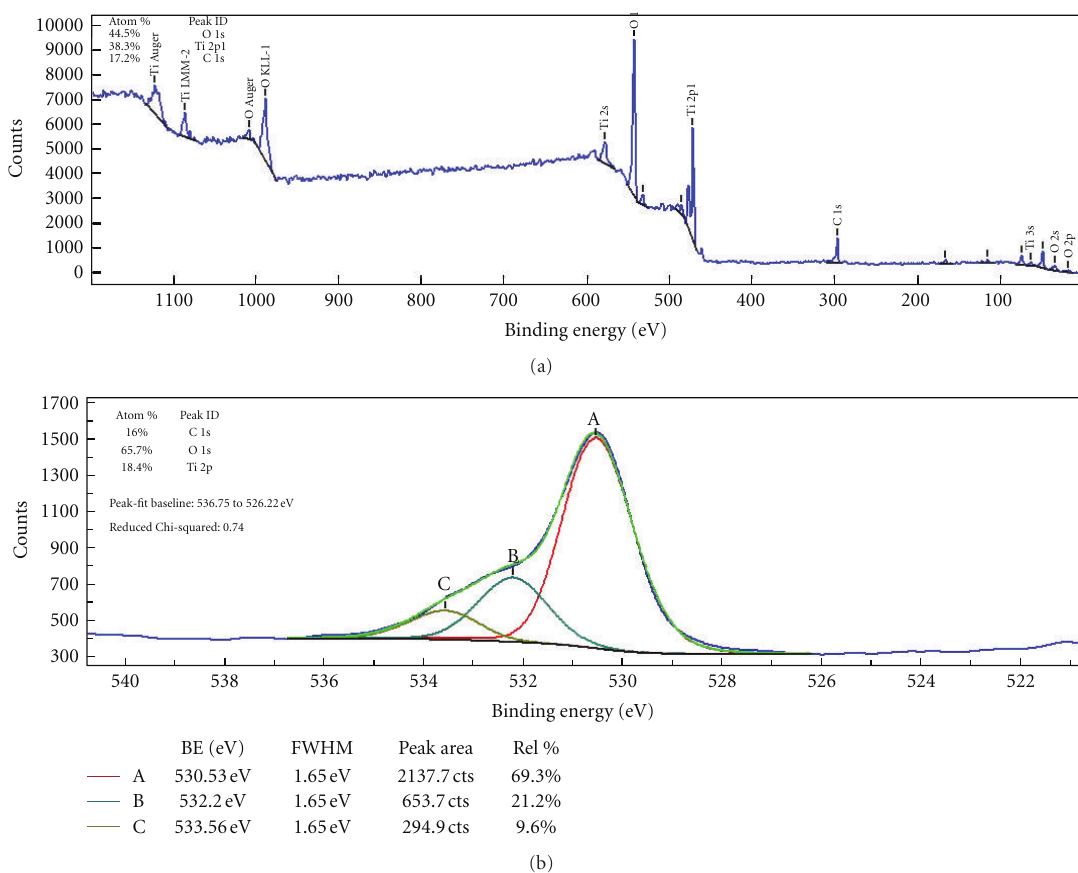
Figure 8: XPS spectra of the TiO 2 thin film (a) and O1s region of the TiO 2 film (b).